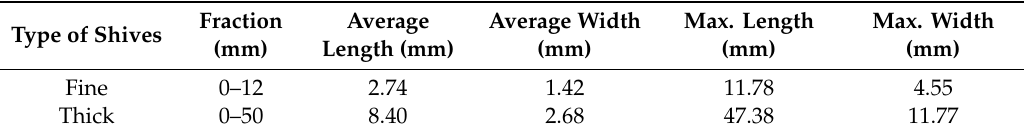
Figure 1. Hemp shives used in the investigation: fine shives ( a ) and thick shives ( b ). The content of shives of individual lengths in the mixture of fine and thick shives is shown in Table 1. The size of the shives was tested on samples weighing 10 g for the thick fraction and 5 g for the fine fraction. They were obtained from material packages delivered by the manufacturers. The measurement was carried out using an electronic caliper and consisted of measuring over 1000 shives fragments from both mixes encompassing the full size spectrum of hemp shives. The mass fractions of constituents in two investigated mix designs are shown in Table 2. Table 1. Sizes of the shives used in the research.